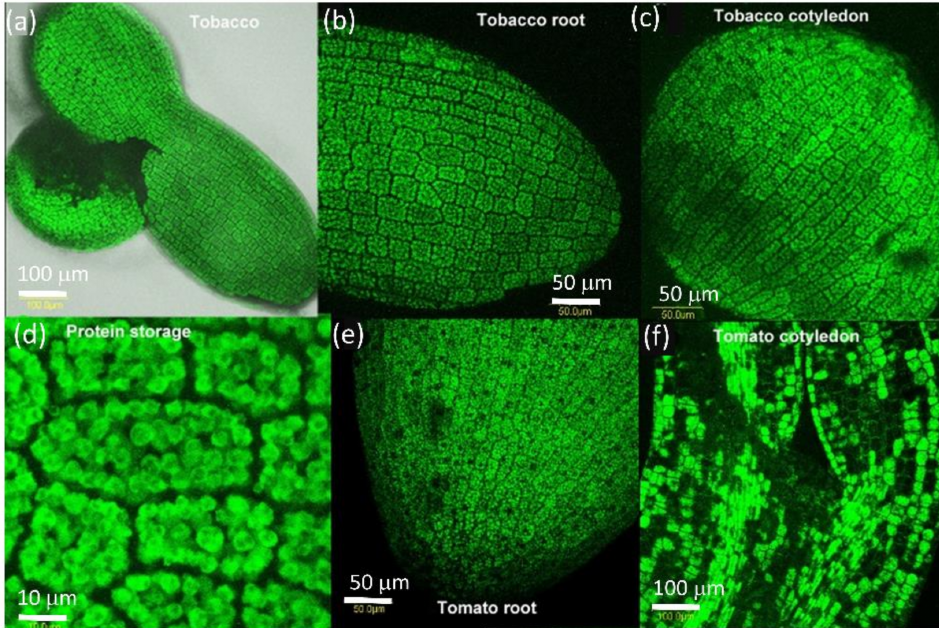
Figure 2. Distribution of PDLP5-GFP in dry seeds of tomato and tobacco. ( a ) Whole dry seed of tobacco, ( b ) close-up of dry tobacco root, ( c ) close-up of dry tobacco cotyledon, ( d ) close-up of dry storage bodies in tobacco root, ( e ) close-up of dry tomato root, ( f ) close-up of dry tomato cotyledon. The bar shows the distance in µ